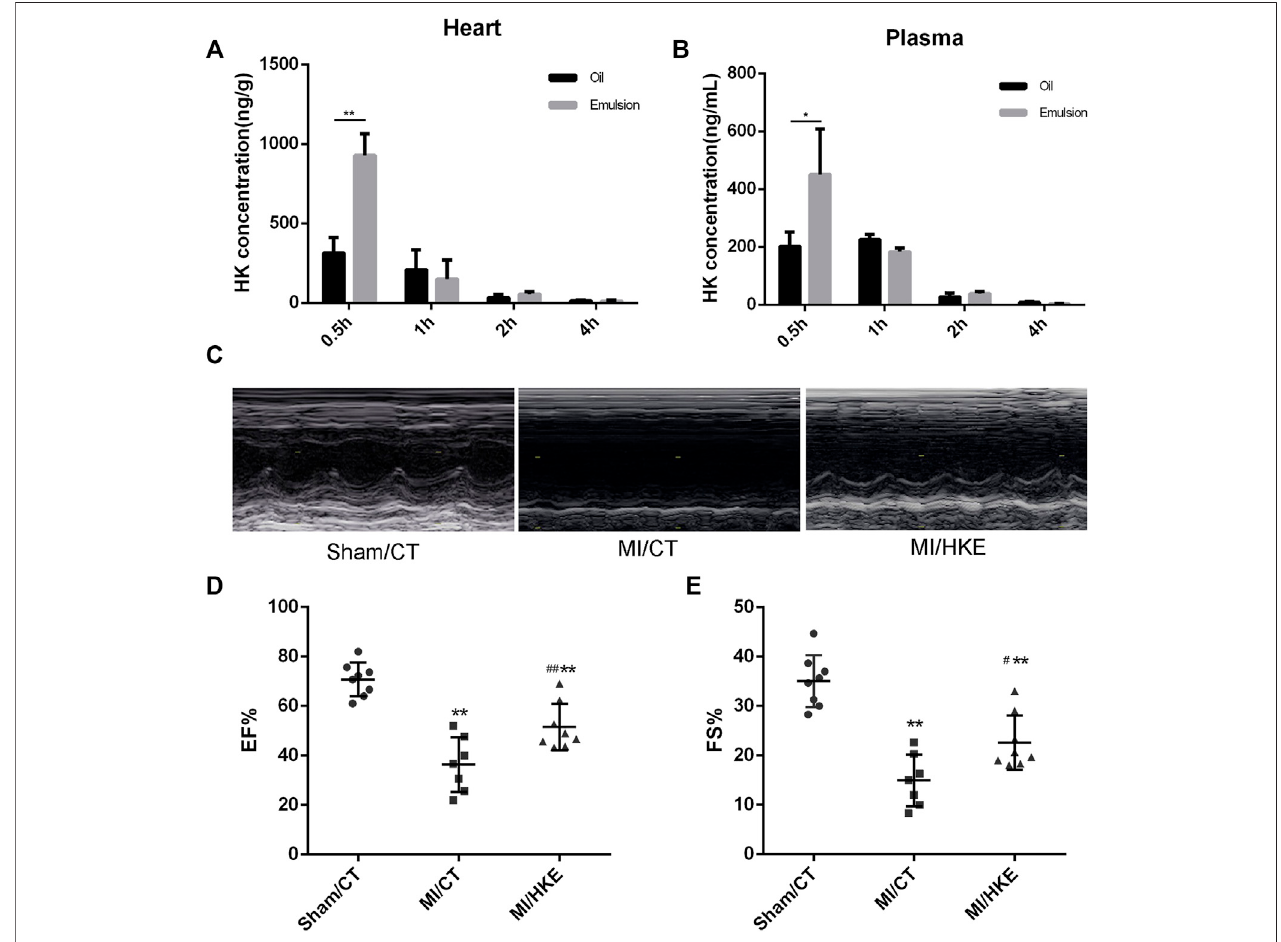
FIGURE 1 | HKE improves cardiac function in post-MI HF. HKE or soybean oil dissolved HK were injected IP (20 mg/kg), and the concentration of HK in heart (A) andplasma (B) weremonitored for0.5,1,2,and4 hafterinjection( n =4pergroup).Four weeksafterMI,EFandFSweredeterminedbyechocardiography (C – E) ( n =7 or 8 per group). Values are shown as means ± SD, * p < 0.05, ** p < 0.01 vs. Sham/CT group, # p < 0.05, ## p < 0.01 vs. MI/CT